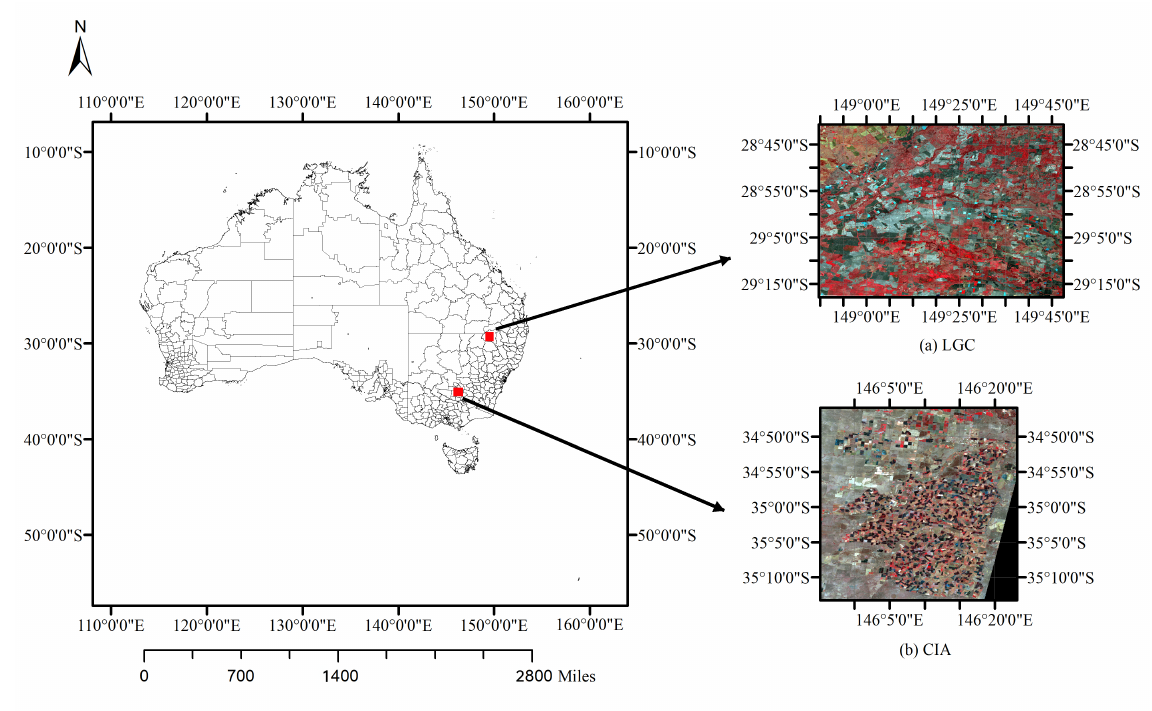
Figure 5. Location of the Coleambally Irrigation Area (CIA) and the Lower Gwydir Catchment (LGC).